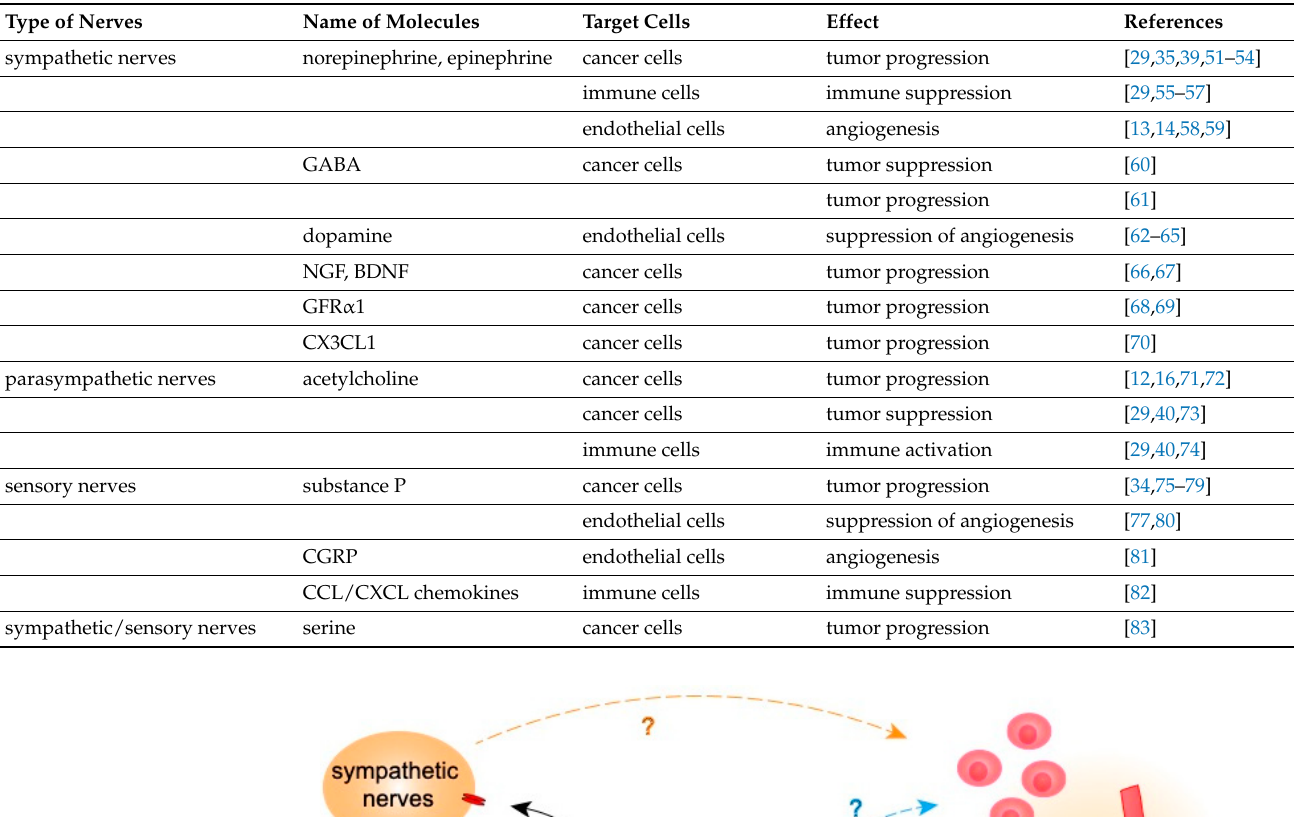
Table 1. Molecules secreted by nerves and their effects on target cells.